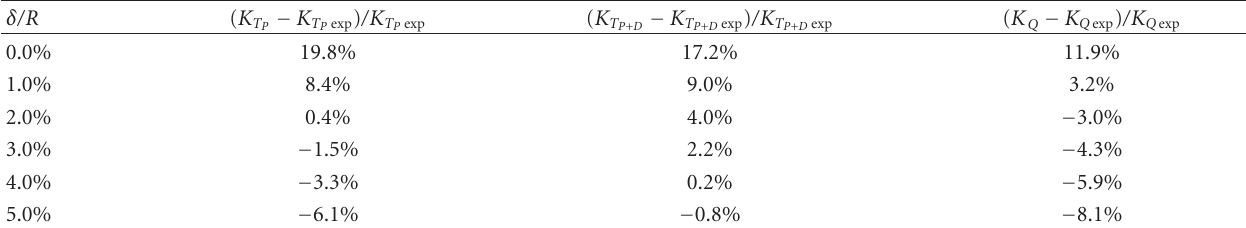
Table 1: Variation with the duct boundary layer thickness of the relative di ff erences between the predicted and experimental (exp) thrust and torque coe ffi cients. Ka4-70 inside duct 19Am at J = 0 . 5. Transpiration velocity gap